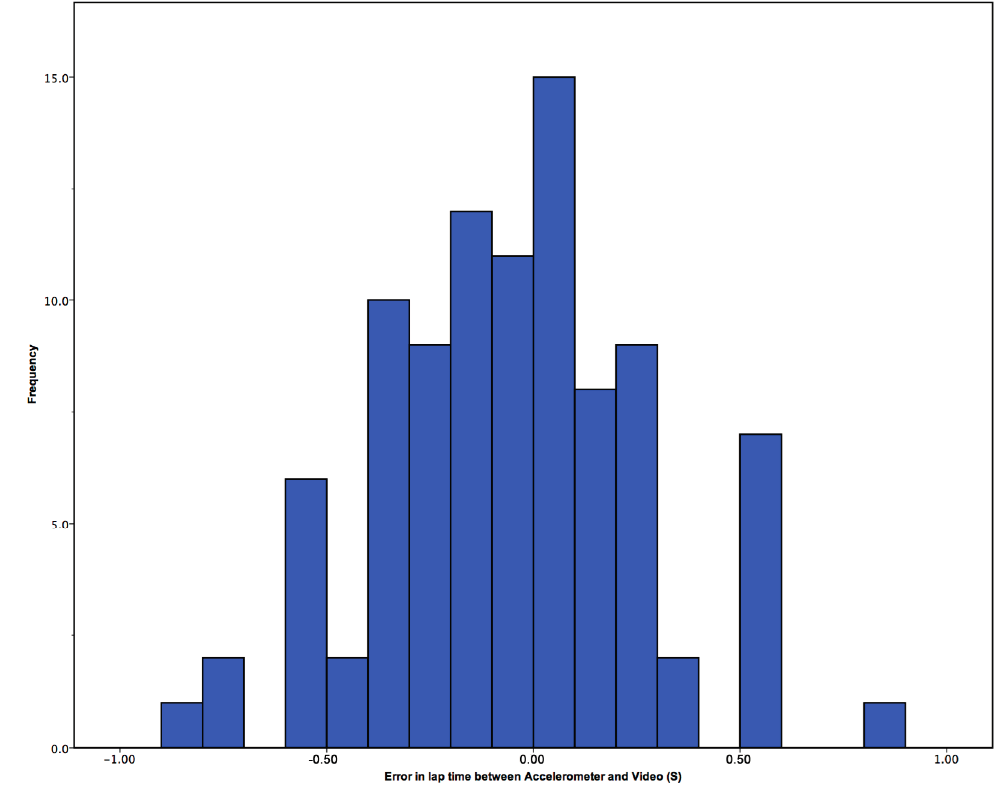
Figure 5. Error in seconds between video and accelerometer for all lap